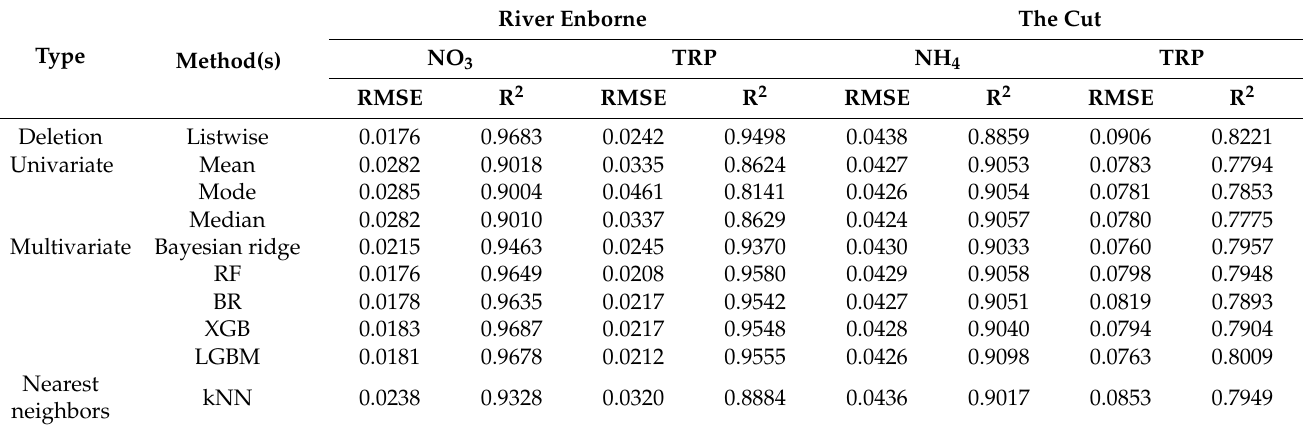
Table 9. Performance comparison of the ET model using different imputation